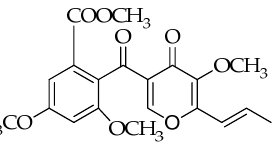
Figure 1. Structure of 3- O -methylfunicone (OMF).